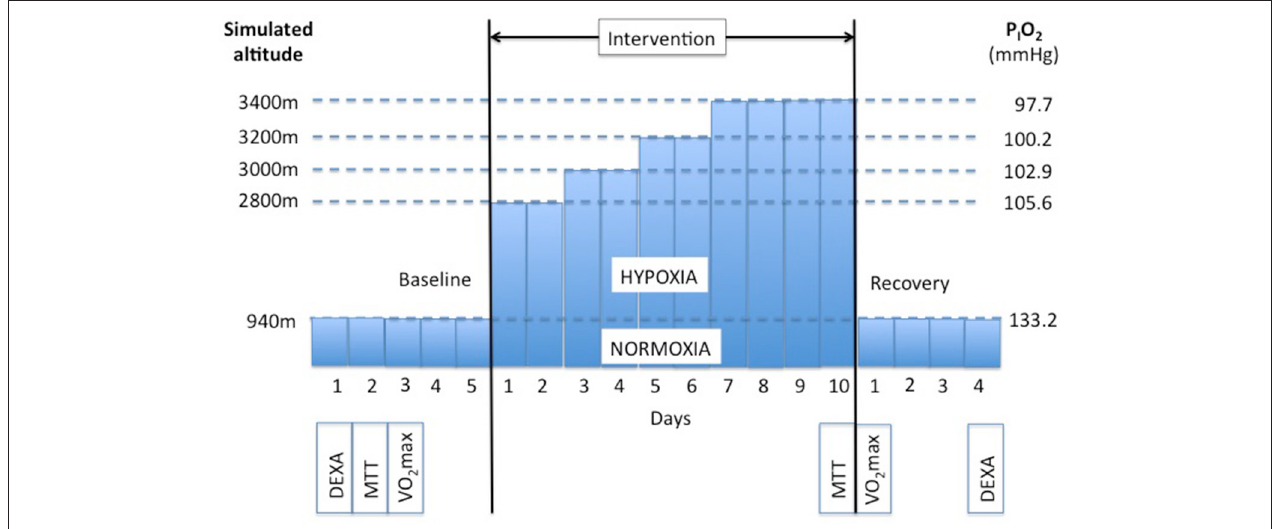
FIGURE 1 | Experimental protocol. Subjects ( N = 11 ) participated in two 10-day confinements. In one they were confined to a normobaric normoxic environment (NORMOXIA), and in the other to a progressive normobaric hypoxic environment (HYPOXIA). Each confinement was preceded by a 5-day period, during which baseline measurements were obtained (DEXA, Body composition was measured with Dual Energy X-Ray Absorption; MTT, Meal Toelrance Test; VO 2 max, maximal oxygen uptake test). Subjects remained at the facility 4 days following each confinement for post